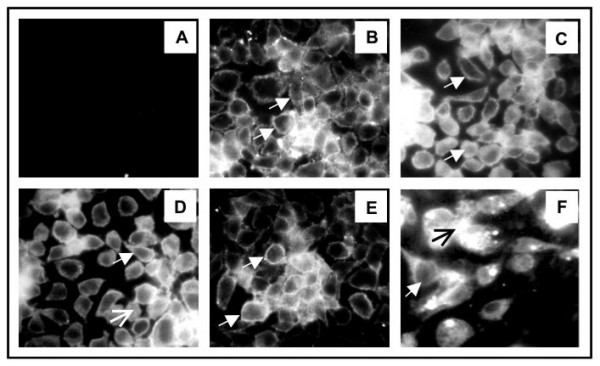
Immunofluorescence microscopy of C6/36 cells. Cell monolayers were stained with pre-immune serum (A), anti-cell membrane (B), anti-MG (C), anti-EP (D), anti-R67 (E) and anti-R80 (F) and then incubated with fluorescein-conjugated goat anti-mouse antibodies.